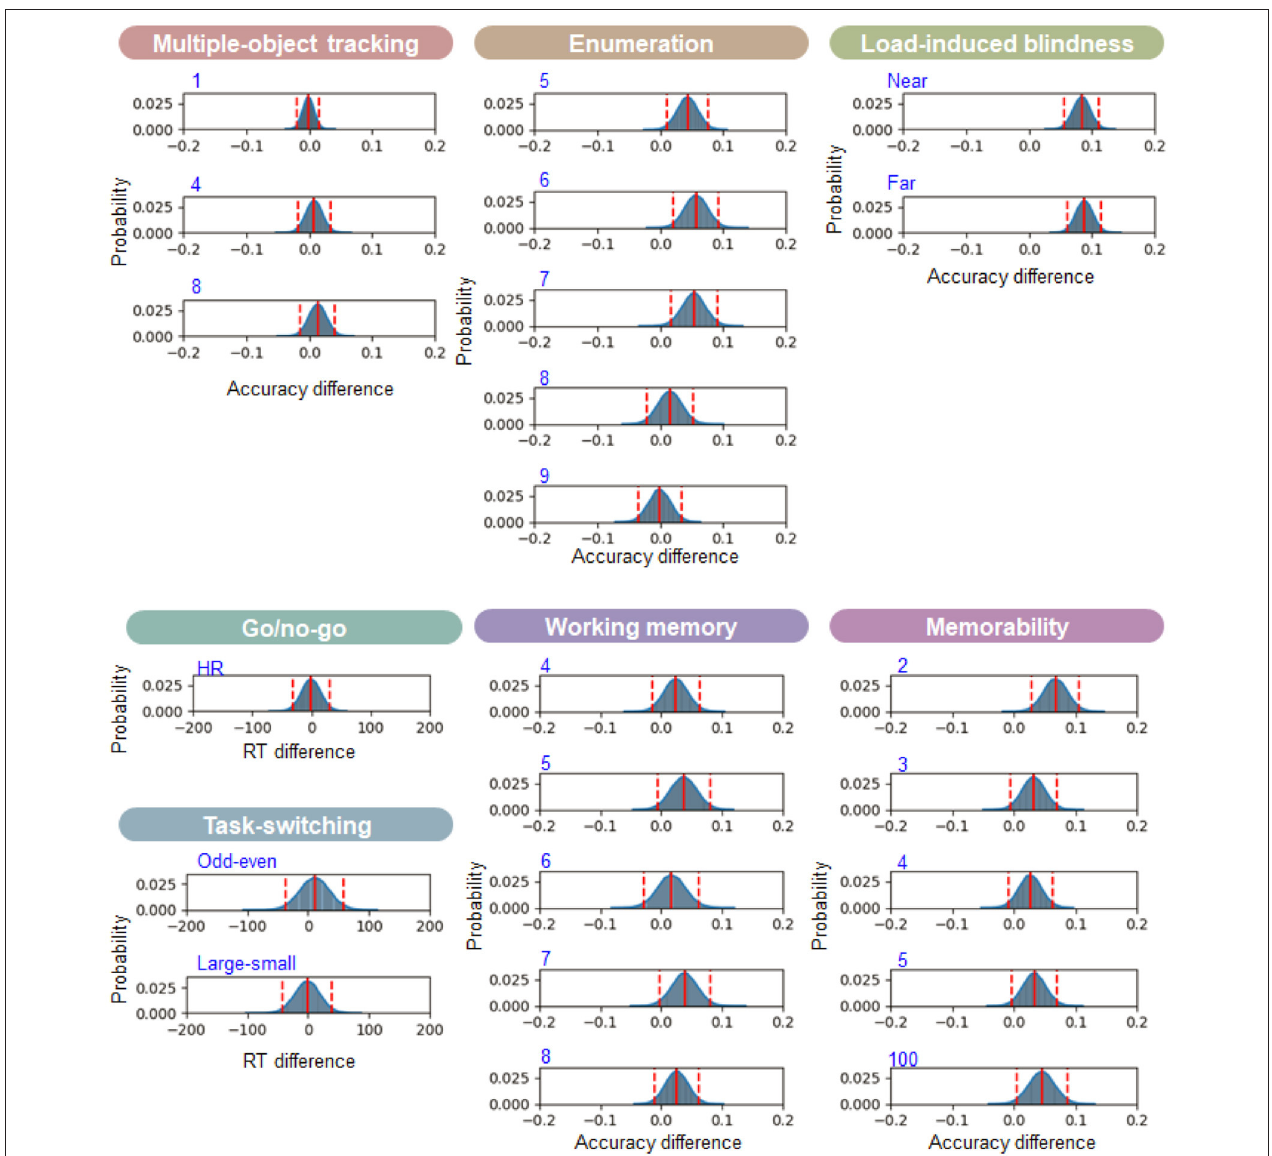
FIGURE 7 | Cross-day performance difference. Each panel shows the probability density of the posterior distribution difference between the first and second-day performance (Day 1–Day 2 for the RT difference and Day 2–Day 1 for the accuracy difference). The positive value means the better performance in Day 2 for either RT or accuracy differences. The vertical red solid and dotted lines indicate the mean and 95% credible intervals, respectively. The condition names put on the left-top for each panel with blue color correspond to the ones shown as the abscissa in Figure 5 . We show here cross-day performance for the parameters used in the latent factor